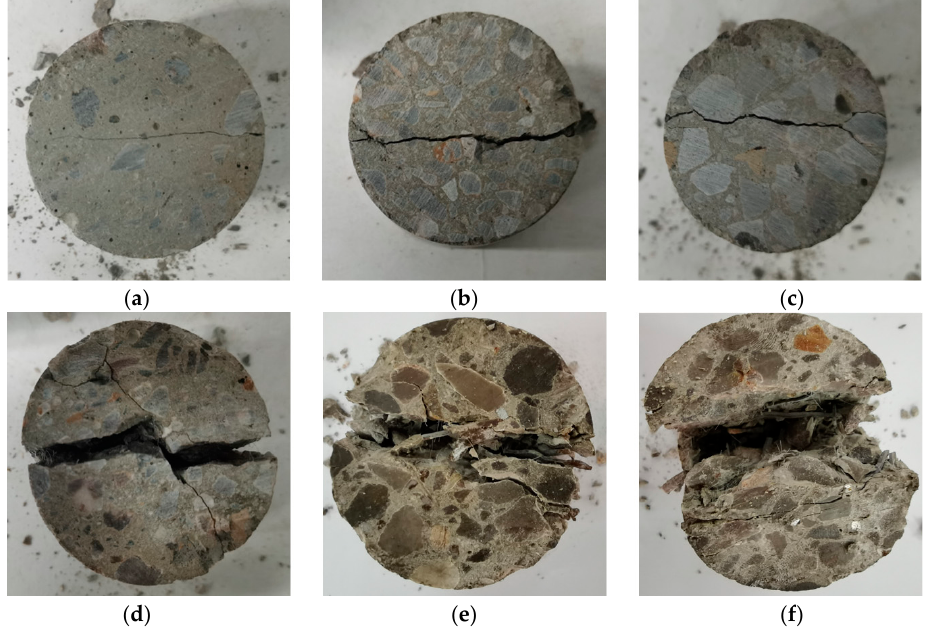
Figure 12. Failure mode of S1PP0.2 concrete at different temperatures: ( a ) 25 °C; ( b ) 100 °C; ( c ) 200 °C; ( d ) 400 °C; ( e ) 600 °C; ( f ) 800 °C.